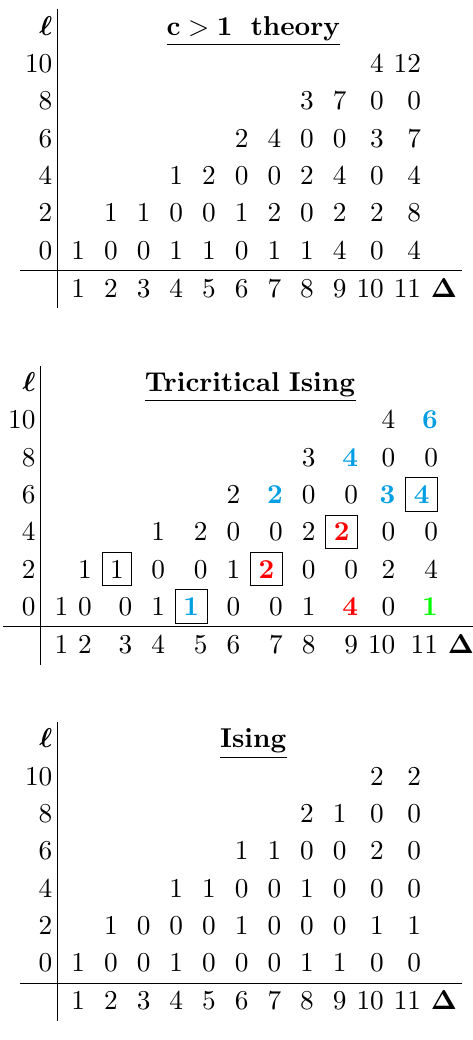
Table 6 . Number of quasi-primary states in the d = 2 h (cid:27)(cid:27)(cid:27)(cid:27) i bootstrap as a function of conformal dimension and spin, for a generic c > 1 theory, the tricritical and critical Ising Model, respectively. Boxed numbers indicate TIM channels that completely disappear in IM; cyan (red) numbers corre- spond to numerically uncertain (unseen) states; the green channel ((cid:1) ; ‘ ) = (11 ; 0) does not appear in the four-spin correlator.